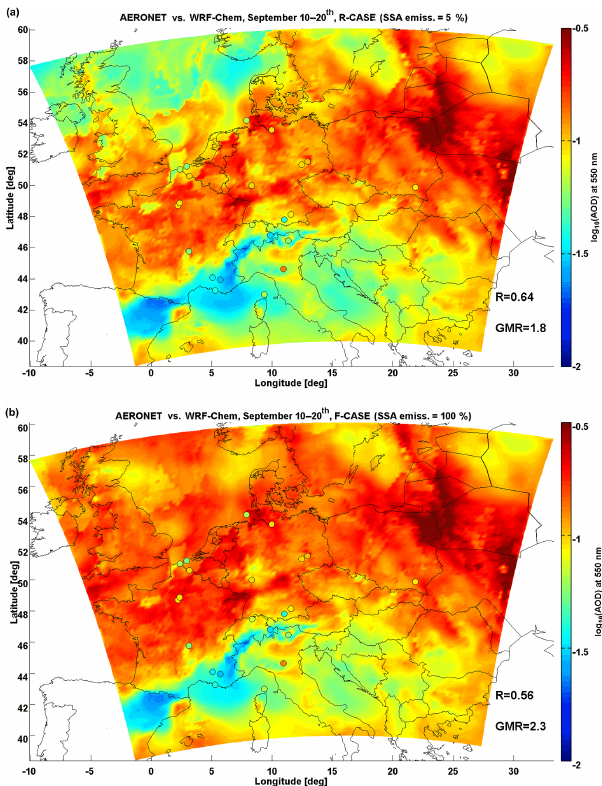
Figure 6. Comparisons of AOD at 550nm wavelength between AERONET measurements and WRF-Chem results, averaged dur- ing 10–20 September. The correlation coefficient ( R ) and geometric mean ratio (GMR) are shown in the figure. The plotted WRF-Chem AOD results are divided by 2 in order to see details with AERONET AOD in one color bar. (a) R-CASE result; (b) F-CASE